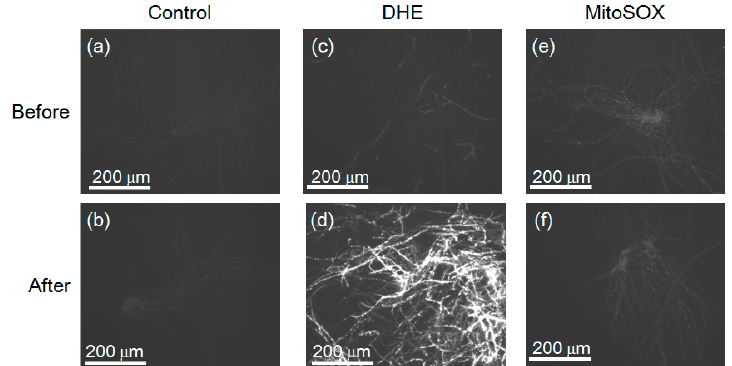
Figure 10. Superoxide levels in the mycelial cells of F. oxysporum before and after treatment of a 5 mM Cd (+) Se IV (+) solution (pH 7.5) at 25 °C were observed by the fluorescence microscope. ( a ) The mycelial cells of F. oxysporum incubated without any reagents before treatment of a cadmium and selenium solution; ( b ) The mycelial cells of F. oxysporum incubated without any reagents after treatment of a cadmium and selenium solution; ( c ) The mycelial cells of F. oxysporum incubated with dihydroethidium (DHE) before treatment of a cadmium and selenium solution; ( d ) The mycelial cells of F. oxysporum incubated with DHE after treatment of a cadmium and selenium solution; ( e ) The mycelial cells of F. oxysporum incubated with mitoSOX before treatment of a cadmium and selenium solution; ( f ) The mycelial cells of F. oxysporum incubated with mitoSOX after treatment of a cadmium and selenium solution.